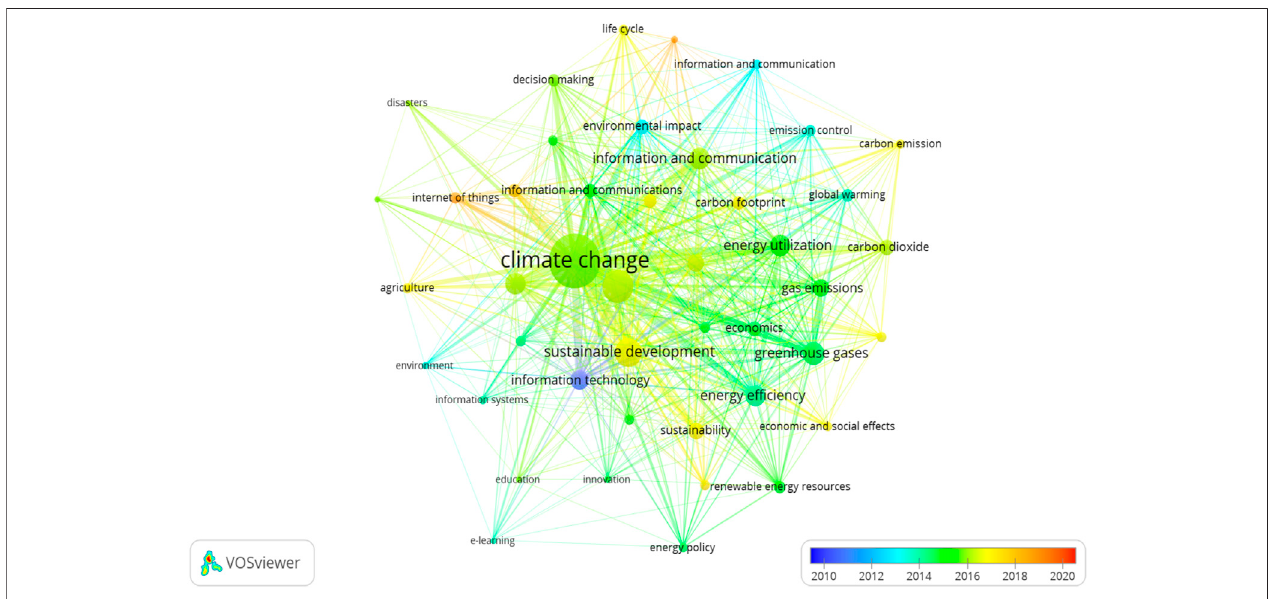
FIGURE 5 | Evolution of research on ICT in climate change over